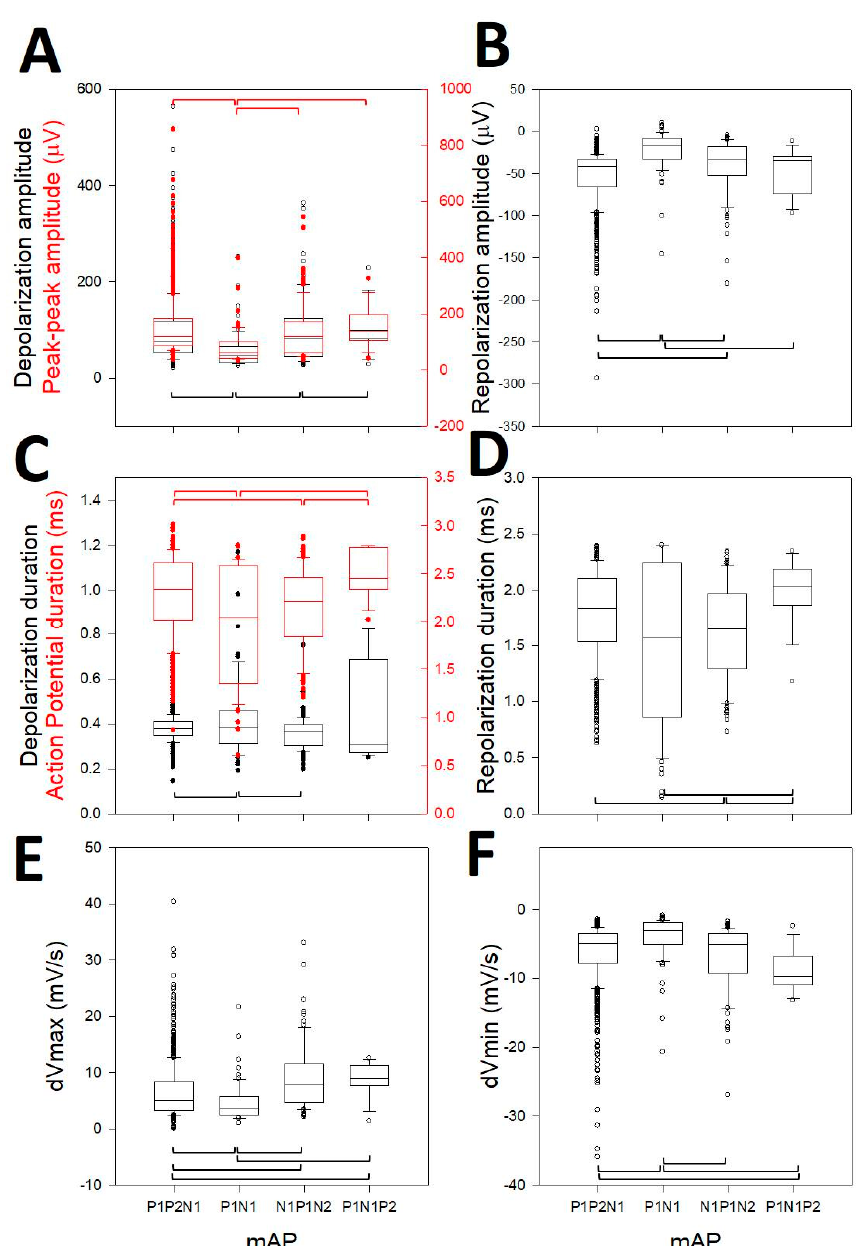
Figure 4. Box-plot graphs showing di ff erent properties of mAPs, indicated at x -axis. ( A ) Depolarization (black) and peak-to-peak (red) amplitudes; ( B ) amplitude repolarization; ( C ) depolarization (black) and action potential (red) duration; ( D ) repolarization duration; ( E ) dVmax and ( F ) dVmin. Horizontal brackets indicate the di ff erence (Kruskal–Wallis One Way Analysis of Variance on Ranks, Dunn’s test post-hoc) with post hoc test between pairs of variables. Red brackets refer to whole action potential variables (peak-to-peak and total